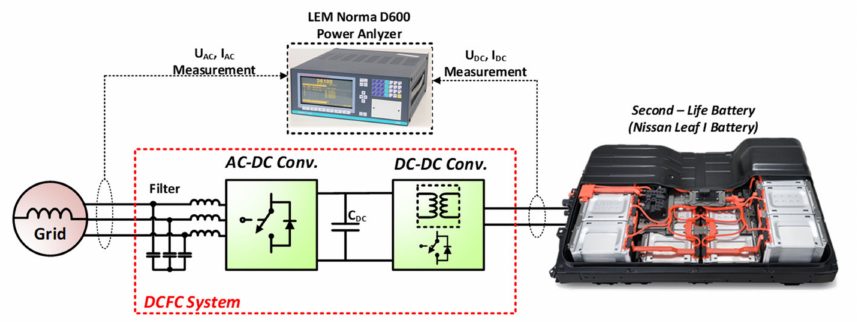
Figure 19. Configuration of the experimental test bench for efficiency measurement.